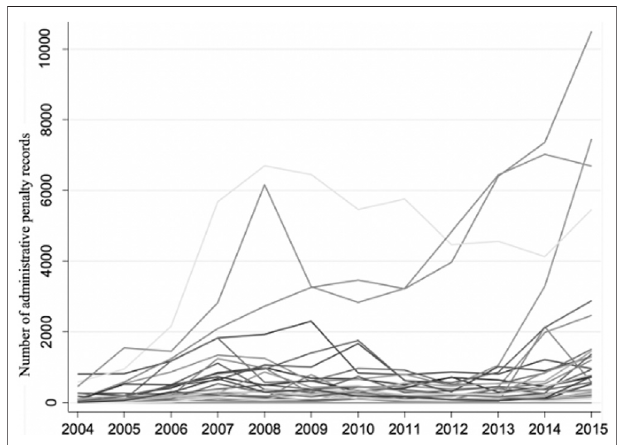
FIGURE 1 | Number of environmental penalties in each Chinese province from 2004 to 2015 (unit: